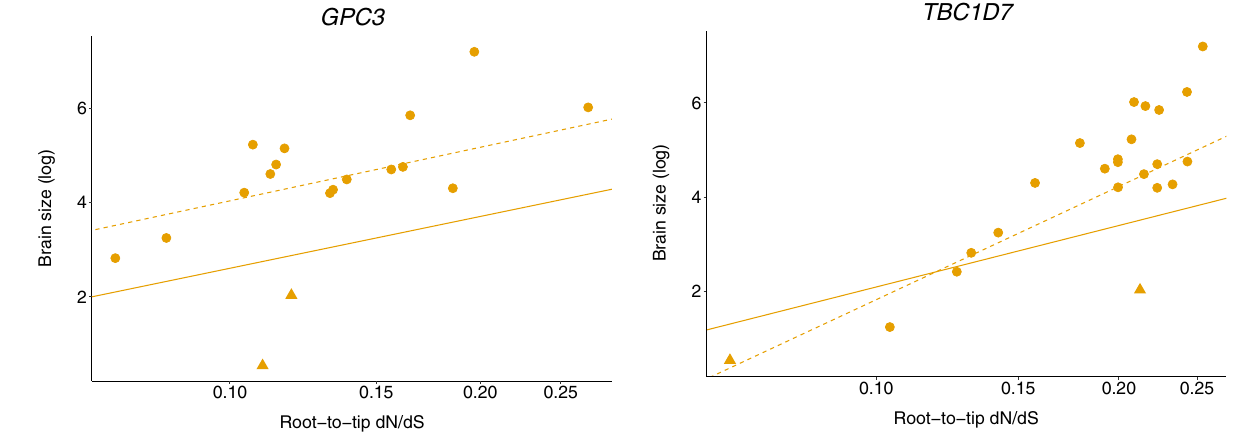
Figure 1. Two candidate genes exhibit associations between selection pressure and brain size in a subset of analyses. We present PGLS regression models of absolute brain size (log) ~ root-to-tip d N /d S (log) for GPC3 (left) and TBC1D7 (right). Each species is represented by a data point. The regression lines from models including all species are solid and those from models excluding Callithrix jacchus and Microcebus murinus are dashed. Callithrix jacchus and Microcebus murinus are represented by triangles. Regressions are significant (nominal p < 0.05) only when Callithrix jacchus and Microcebus murinus are excluded (see “Methods”, Table 2, Supplementary Table